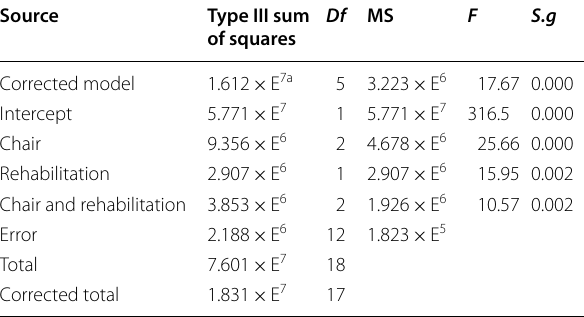
Df degree of freedom, F statistical parameter calculated by mean squares (MS) R 2 0.880 (adjusted R 2 = =